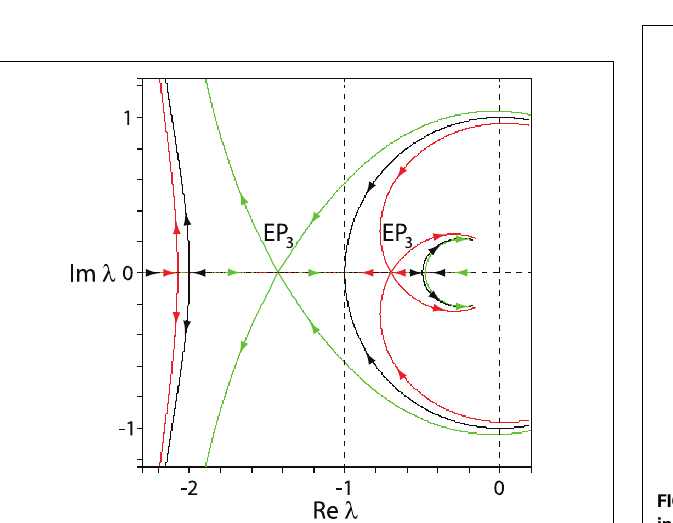
FIGURE 4 | Trajectories of roots of the polynomial (5) when a 2 increases from 0 to 15 and: a 1 = a 3 = 3 . 7 (black); a 1 = 3 . 7, a 3 = 3 . 6 (red); a 1 = 3 . 6, a 3 = 3 . 7 (green).